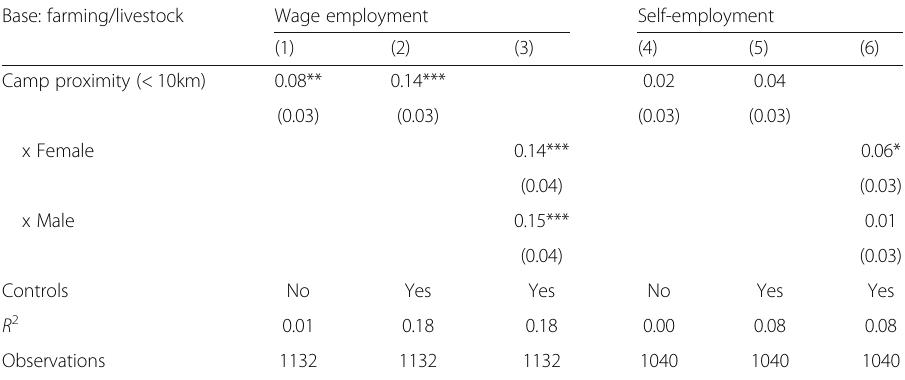
Table 12 Limited sample, primary daily activity Base: